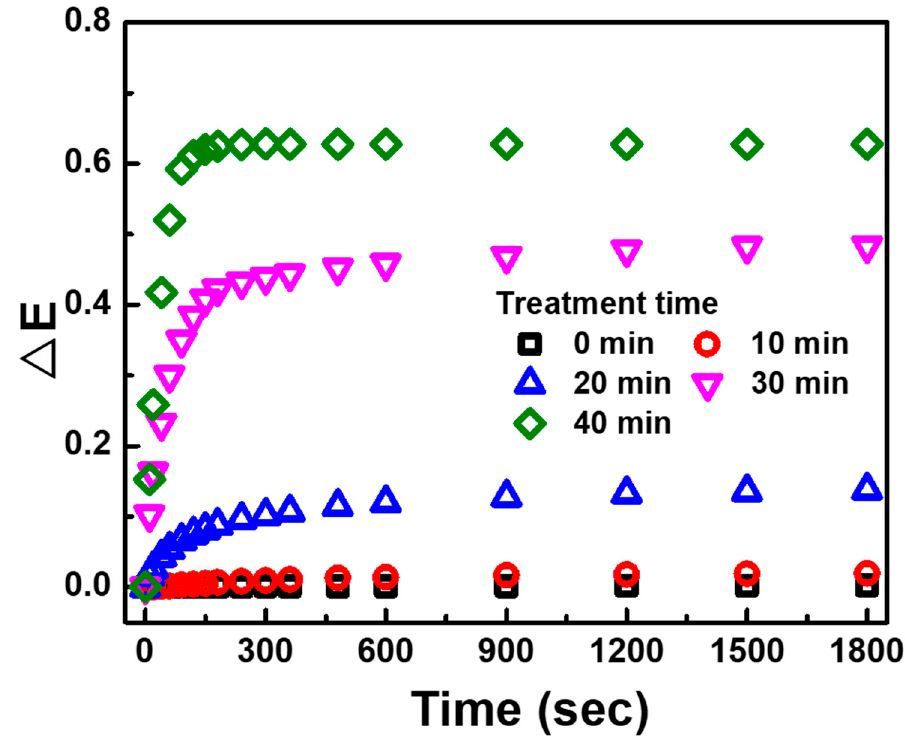
Figure 4. Extinction change of PANI/P3TI/PMMA fibers exposed to 2000 ppm n-butanol with various UV/ozone treatment time.